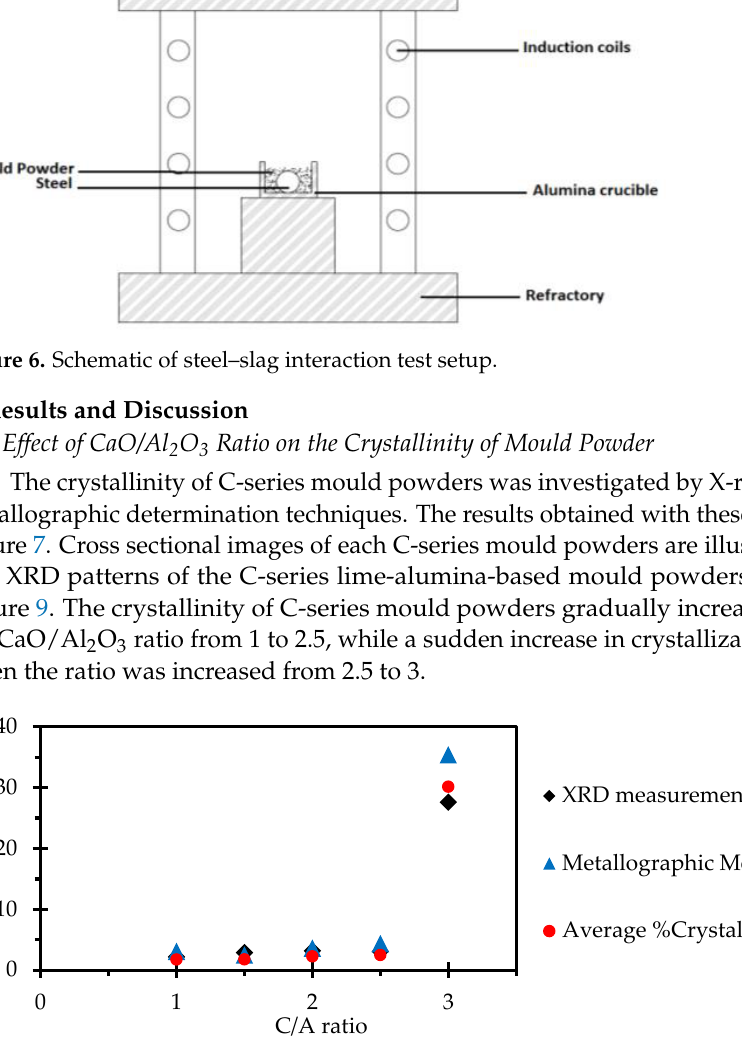
Figure 7. The percent crystallinity in C-series mould powders as a function of C/A ratio.